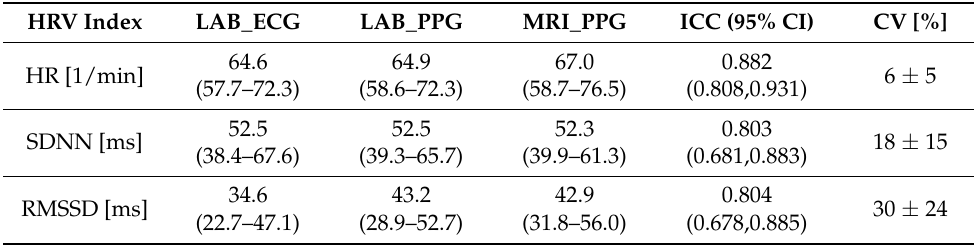
Table 3. HRV indices derived from photoplethysmogram recordings in the laboratory and during MRI compared to electrocardiograms in the laboratory (N = 55).